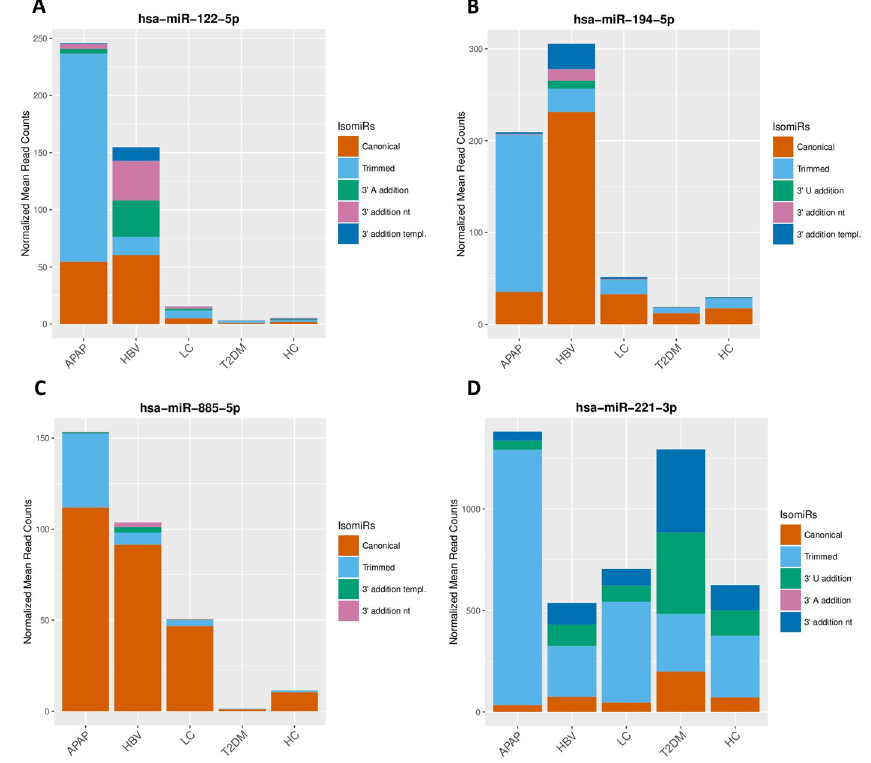
Fig 5. Different isomiR spectrums in APAP, HBV and T2DM. The figure presents the isomiRcomposition, basedon normalizedmean sequencing reads, in APAP, HBV, LC, T2DM an HC for miR-122-5p (A), miR-194- 5p (B), miR-885-5p (C) and miR-221-3p